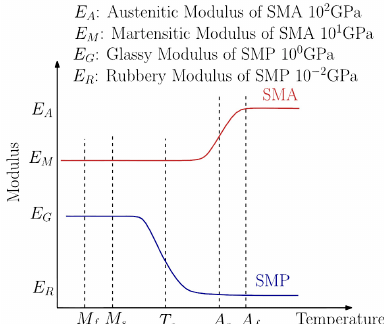
Figure 7. Modulus as a function of temperature for SMP and SMA, schematically. Note: this figure emphasizes the effect of the corresponding transformation (“switching”) temperatures ([178], reproduced with permission from Elsevier).